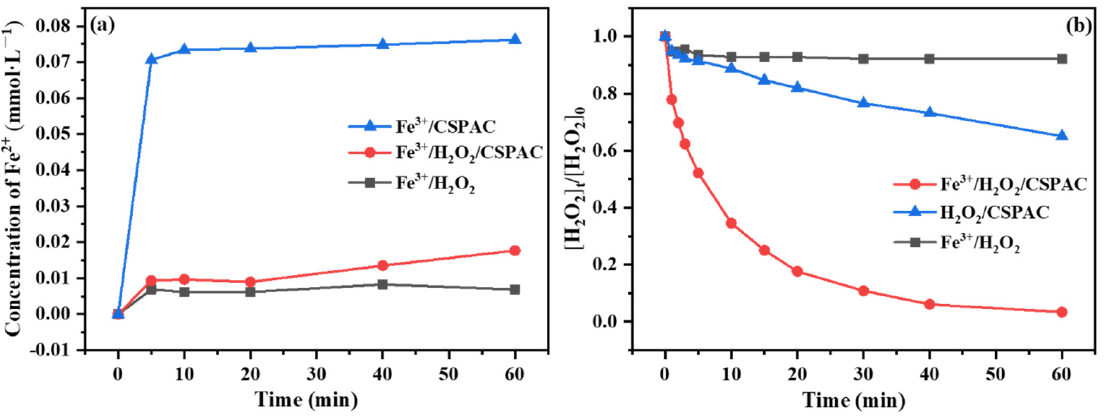
Figure 9. ( a ) Generation of Fe 2+ and ( b ) degradation of H 2 O 2 in different systems (0.1 mmol/L FeCl 3 , 0.4 mmol/L H 2 O 2 , 0.6 g/L CSPAC (75 μ m particle size), pH = 3).